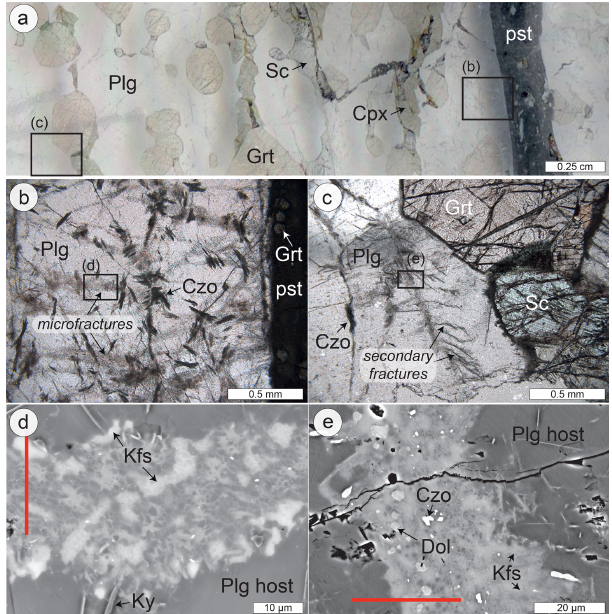
Figure 1. Fractured wall rock plagioclase. (a) Thin section scan of wall rock plagioclase (Plg), garnet (Grt), clinopyroxene (Cpx) and scapolite (Sc) adjacent to an eclogite facies pseudotachylyte (pst) on Holsnøy. (b) Fine-grained reaction products of clinozoisite (Czo) are associated with the microfractures; the box denotes the location of MF1. (c) Some microfractures in plagioclase display secondary cracking; the box denotes the location of MF2. (d) Backscatter elec- tron image of MF1 with fine-grained plagioclase, alkali feldspar (Kfs) and minor kyanite (Ky). (e) Backscatter electron image of MF2 with fine-grained plagioclase, K-feldspar, dolomite (Dol) and clinozoisite. Red lines indicate the location of focused ion beam cuts for TEM analysis shown in Figs.